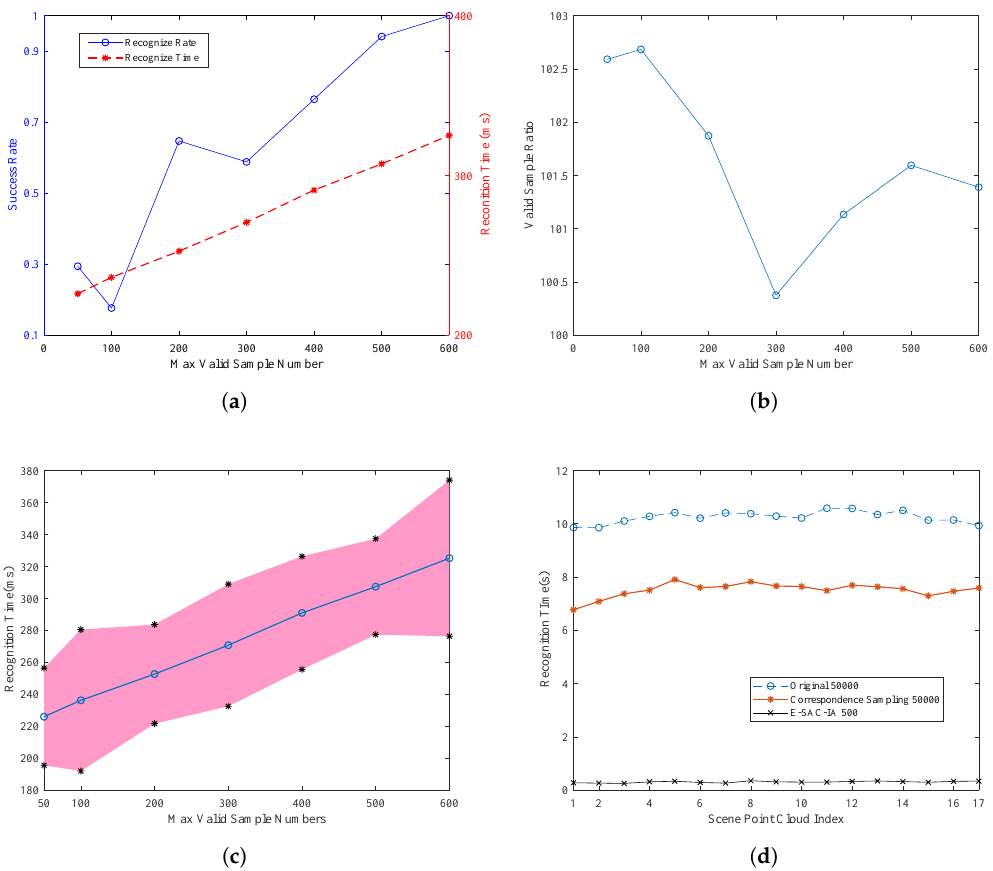
Figure 5. The perfomace comparison between the traditional and improved SAC-IA